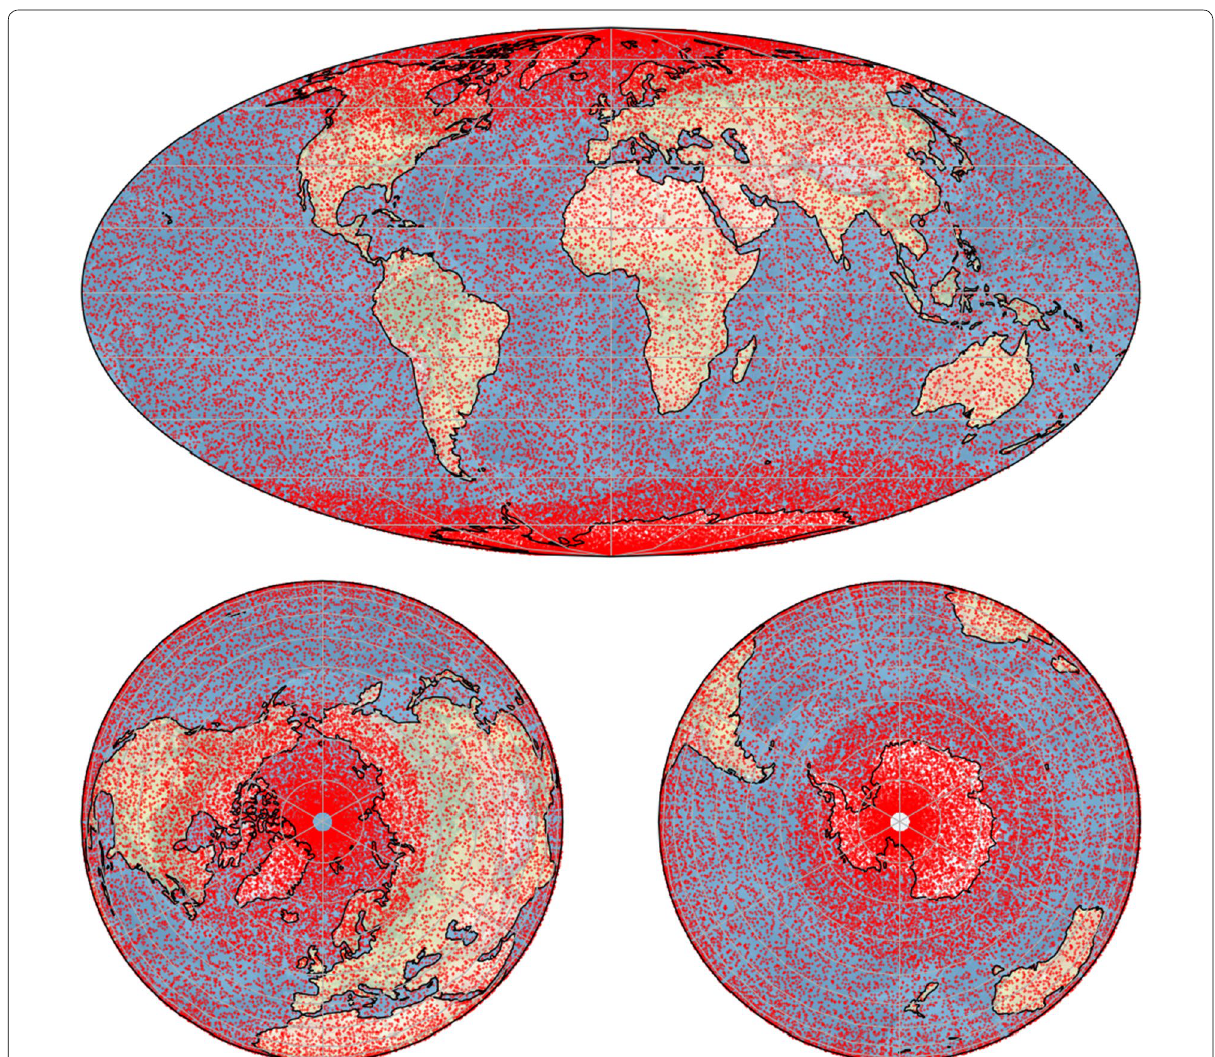
Fig. 1 The location of those measurements used to constrain the initial magnetic field model. Top: Mollweide projection. Bottom: orthographic projections centred on the North pole (left) and South pole (right). Every third point shown for clarity